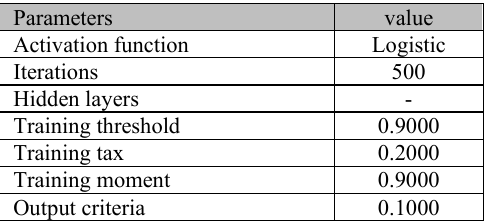
Table 2 . ANN parameters obtained in Weka